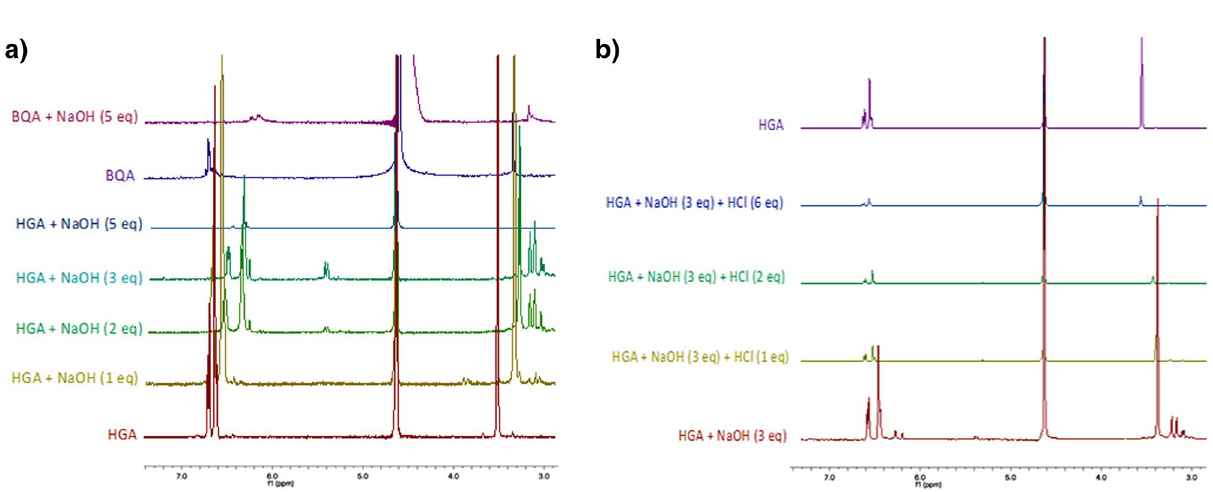
Figure 5. UV spectra of BQA and HGA (0.06 mM) in H 2 O and alkali.